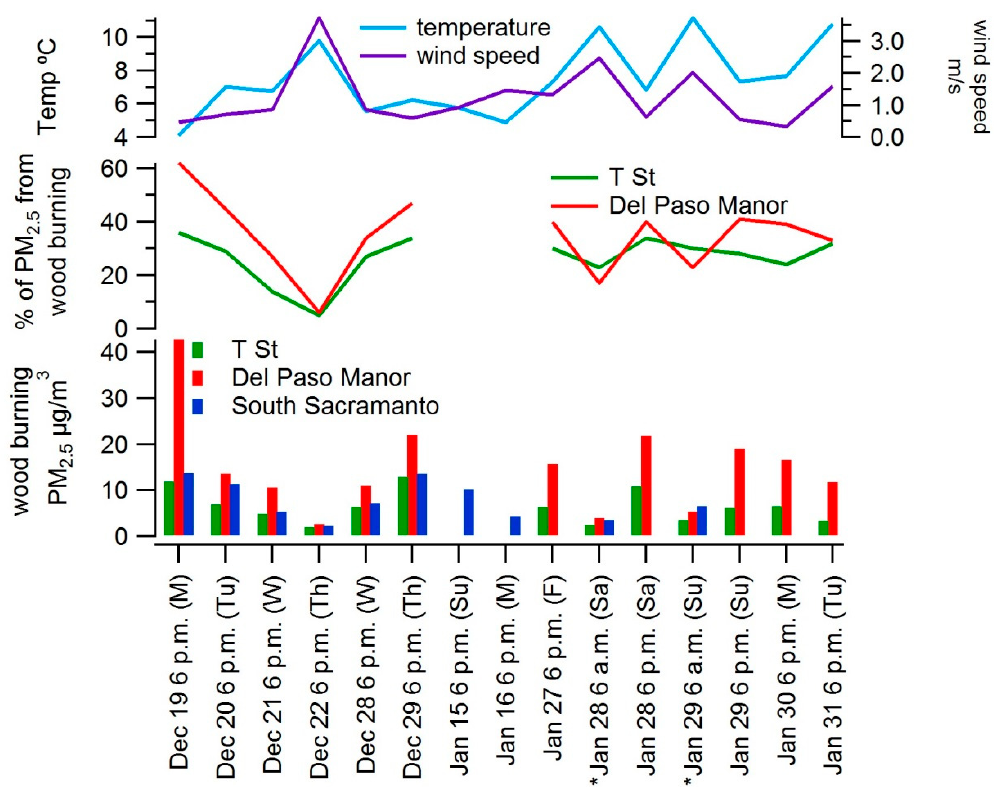
Figure 3. Calculated residential wood burning PM 2.5 (µg/m 3 ) from levoglucosan measurements, percent of PM 2.5 from residential wood burning and temperature and wind speed for each 12 h period when filters were collected; listed time indicates start time of sample and asterisks indicate the daytime samples. Temperature and wind speed data are shown for the T Street (T St) location. Percent of PM 2.5 from residential wood burning is based on hourly measurements for PM 2.5 at T Street and Del Paso Manor.